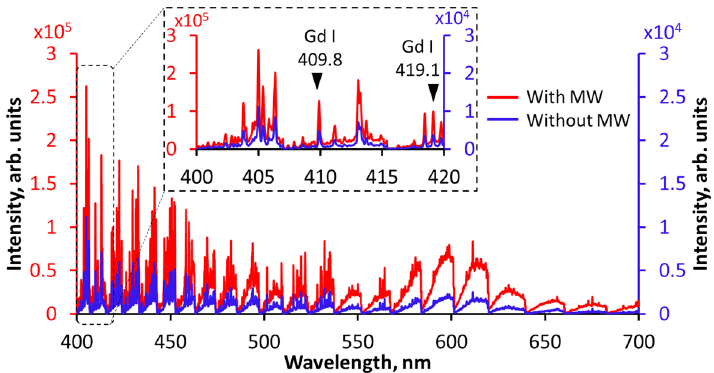
Figure 4. Emission spectra of 99.9% pure Gd 2 O 3 using MWE-FC-MLIBS with ceramic micro-laser and helical coil antenna. The standard emission without the microwaves using the same laser energy of 1.0 mJ is shown for comparison.